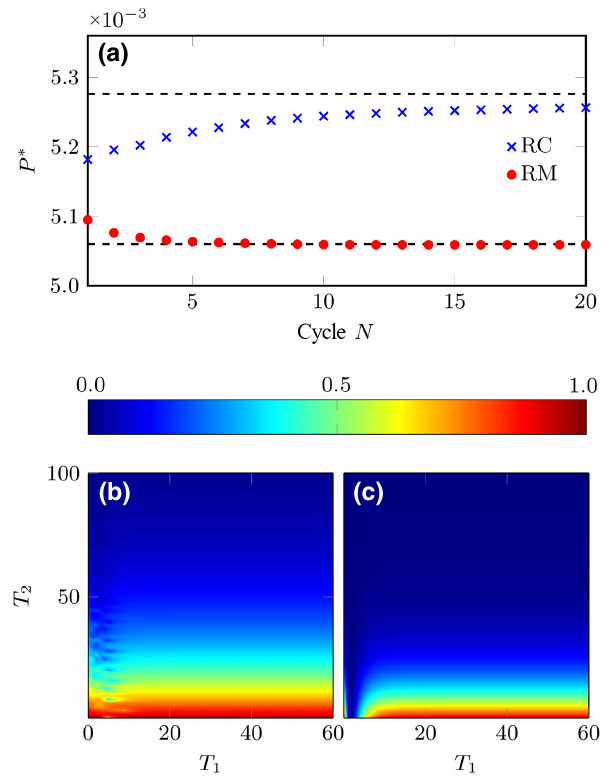
FIG. 6. Maximum power P ∗ , with respect to durations T 1 and T 2 , of the engine as a function of cycle number N for both repeated contacts and repeated measurements, blue and red sym- bols, respectively (a). The dashed lines represent the asymptotic values of maximum power of the engines in their periodic state asymptotically reached after many cycles, see Appendix B. The deviations of the engine from this limiting behavior decay expo- nentially as the cycle number increases. (b) The slowest decaying factor (cid:20) 2 (see Appendix B last paragraph for definition) in engines monitored by repeated contacts, while (c) is the corre- sponding plot of engines being repeatedly measured. The initial condition for the engine in (a) is again given by the according invariant state ρ ∗ as in the previous figures. The other parameters = 1, (cid:11) = 3.7, θ = (cid:11) τ = (cid:11) τ = 8, β = 0.25, β = 0.025, (cid:11) c h c c h h c h and γ = 0.025 are the same as in Fig.